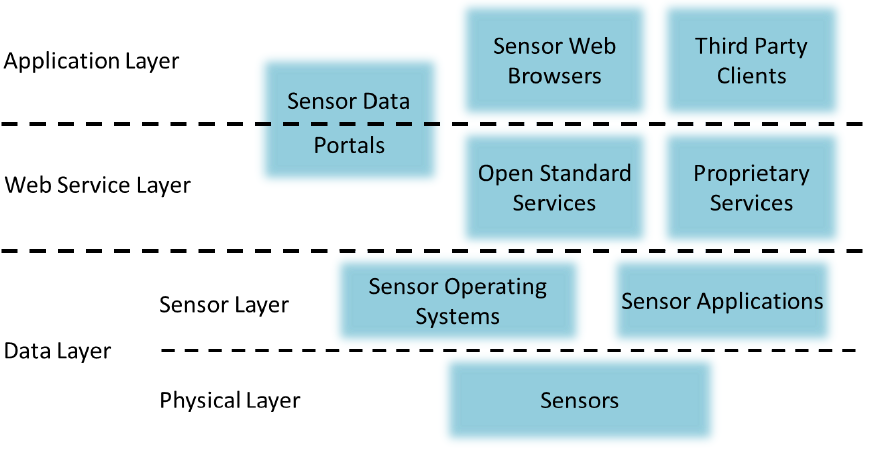
Figure 2. The sensor web layer